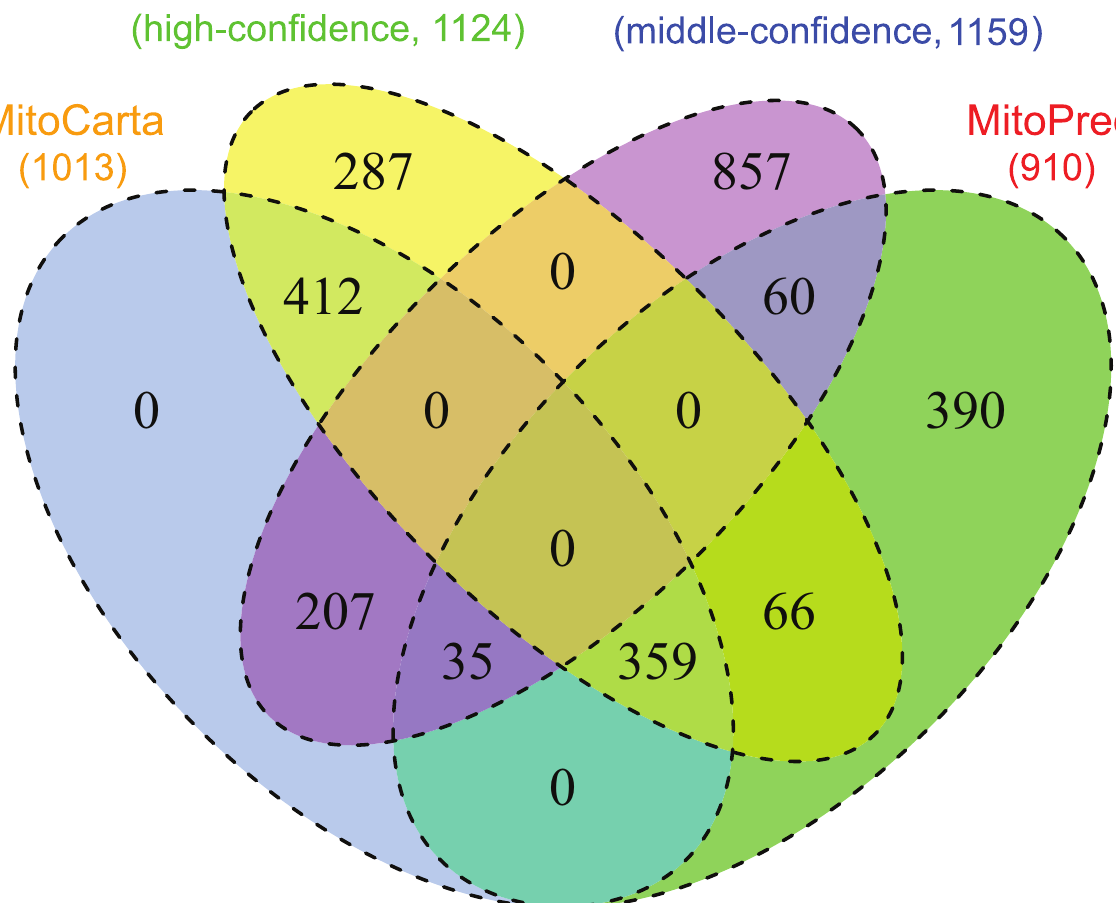
Figure 2. Venn diagram of the four datasets: MitoCom (high-confidence), MitoCom (middle-confidence), MitoCarta and MitoPred.